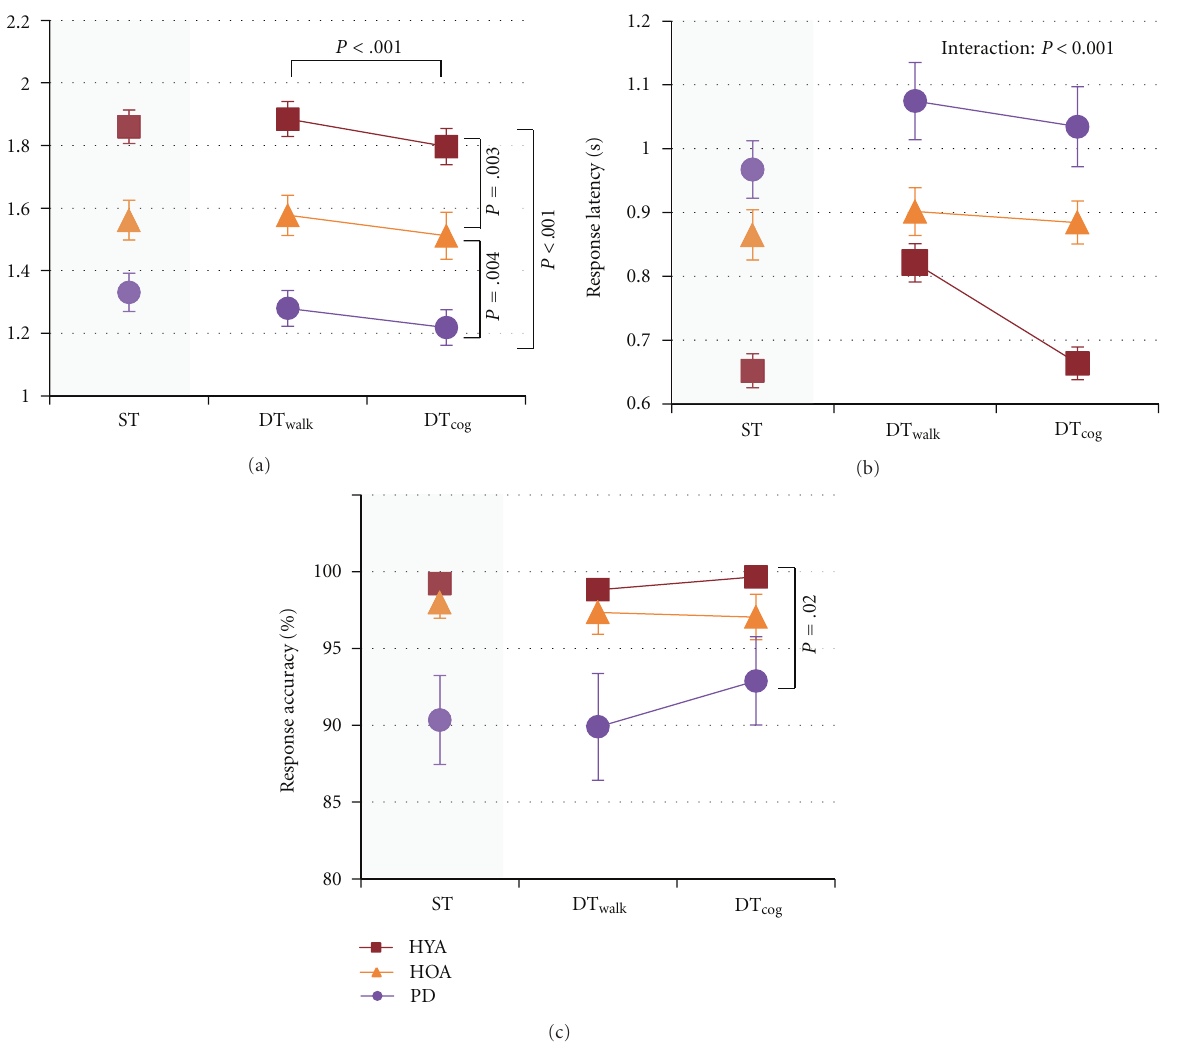
Figure 1: Gait speed (a), response latency (b), and response accuracy (c) for all groups in the single-task (ST; for reference) and both dual- task conditions. Red squares show data for healthy young adults. Orange triangles show data for healthy older adults. Purple circles show data for people with PD. Symbols represent means and bars show standard